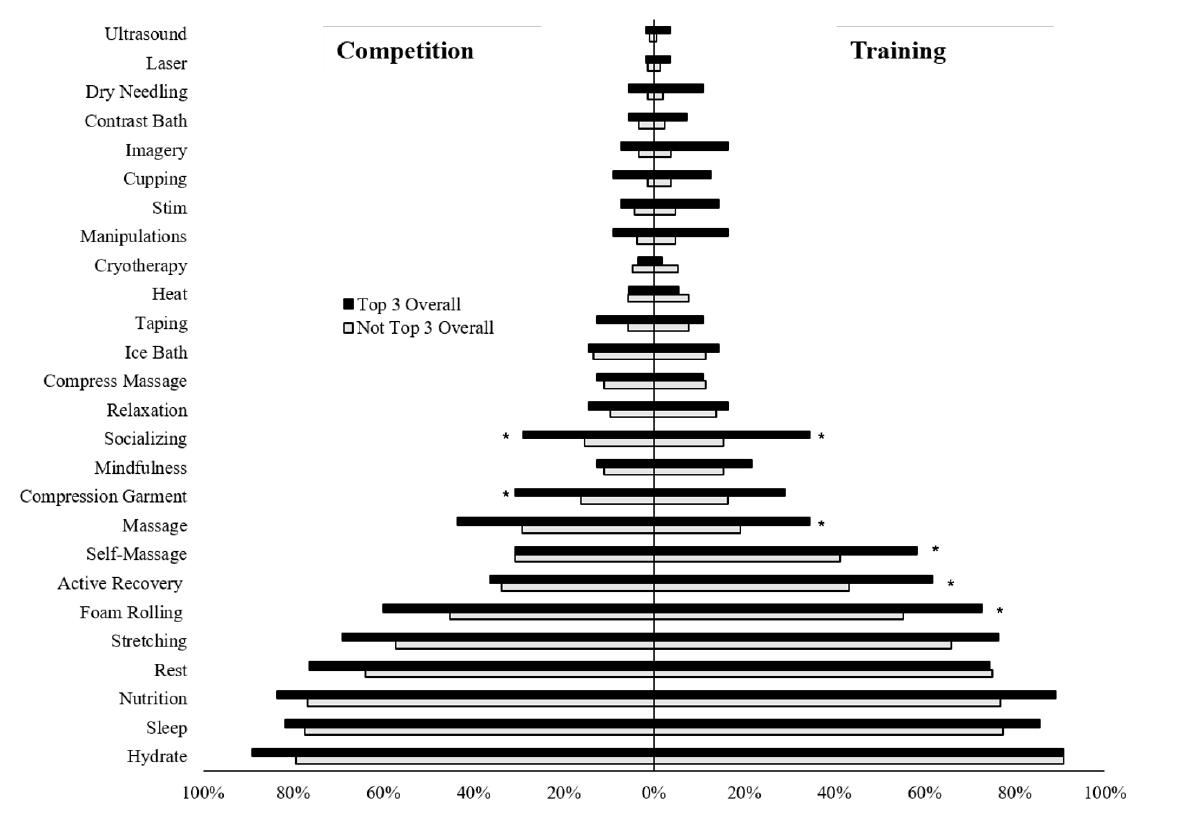
Figure 2. Recovery strategy used by the top three overall in a competition. Note. * = p < 0.05. Table 3. Use of recovery strategy by belief in the